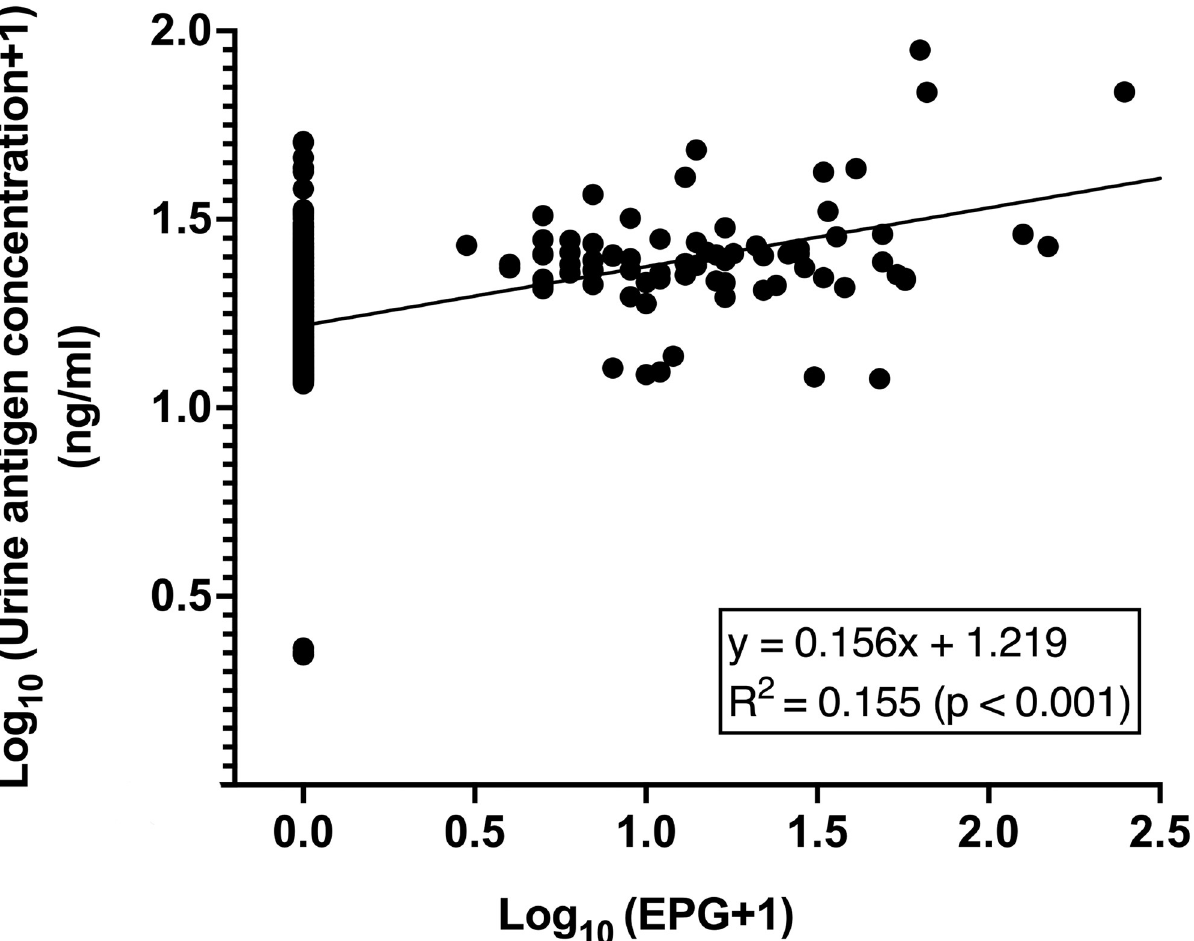
Fig 3. Relationship between log-transformed fecal egg counts of O . viverrini (EPG) and log-transformed concentrations of antigen in urine (ng/ ml) in 801 individuals from Northeast Thailand. Data points shown are observed values, where the egg counts plus one are log 10 transformed (x-axis) and the antigen concentrations are log 10 transformed (y-axis). The solid line represents a best-fit linear-regression with an intercept of 1.219 and a slope of 0.156 (Spearman’s range correlation test, p < 0.001).